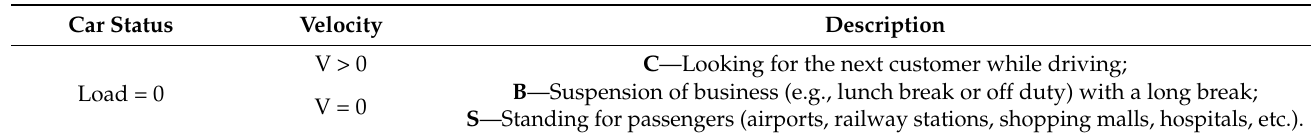
Table 2. The three situations of unoccupied trip.